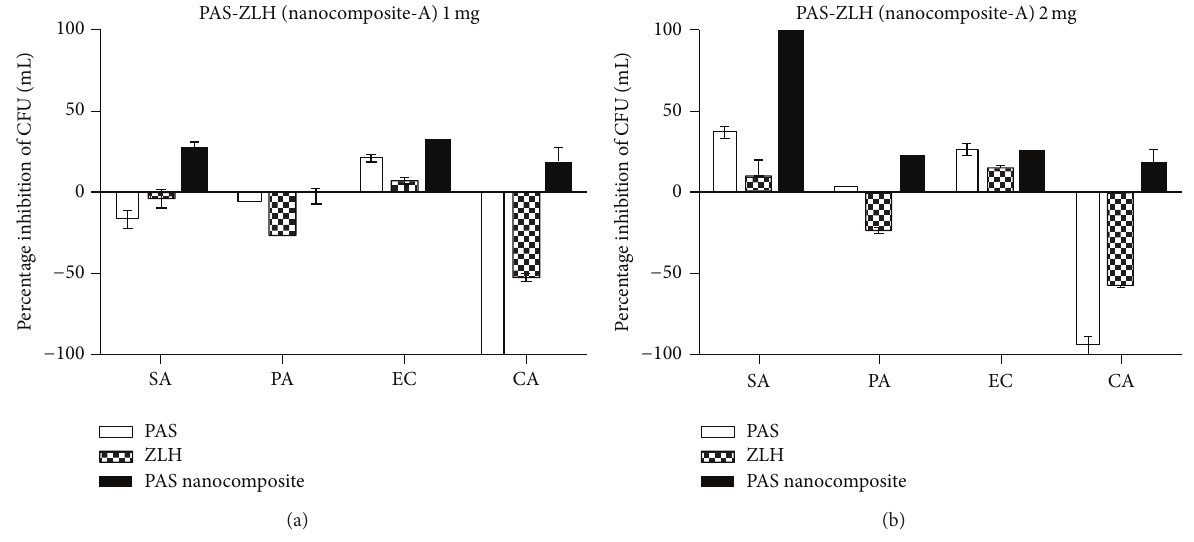
Figure 10: Effect of PAS-ZLH (nanocomposite-A) on the inhibition of microbial growth using the plate colony counting method at two concentrations ((a): 1mg) and ((b): 2mg). CFU: colony-forming units; SA: Staphylococcus aureus ; PA: Pseudomonas aeruginosa; EC: E. coli ; CA: Candida albicans .